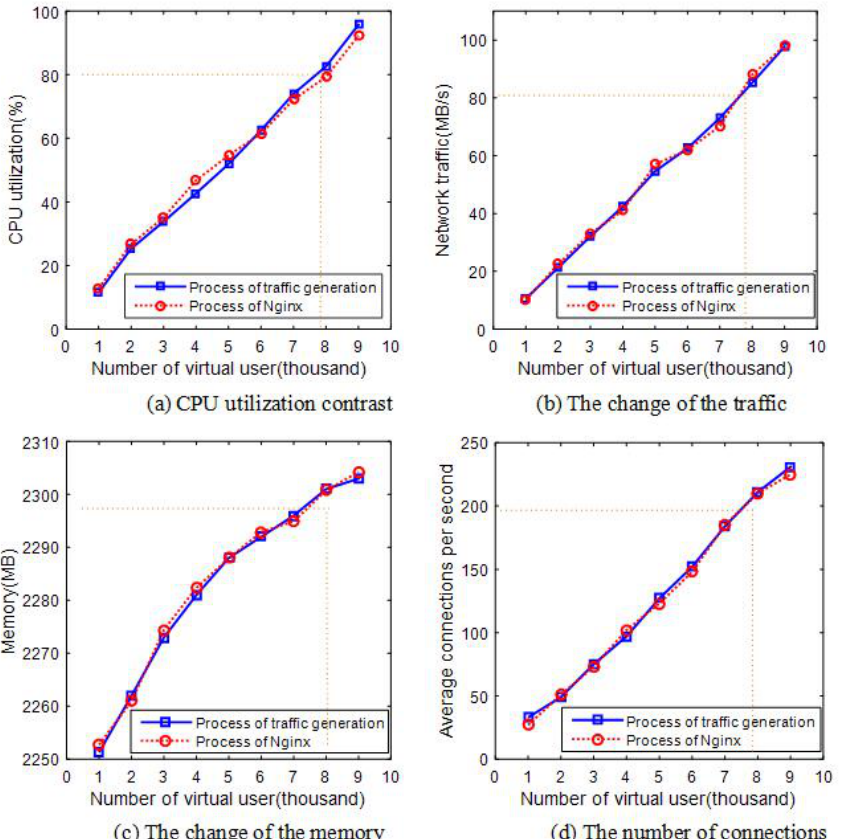
Figure 15. A single traffic generation process comparing the concurrency with